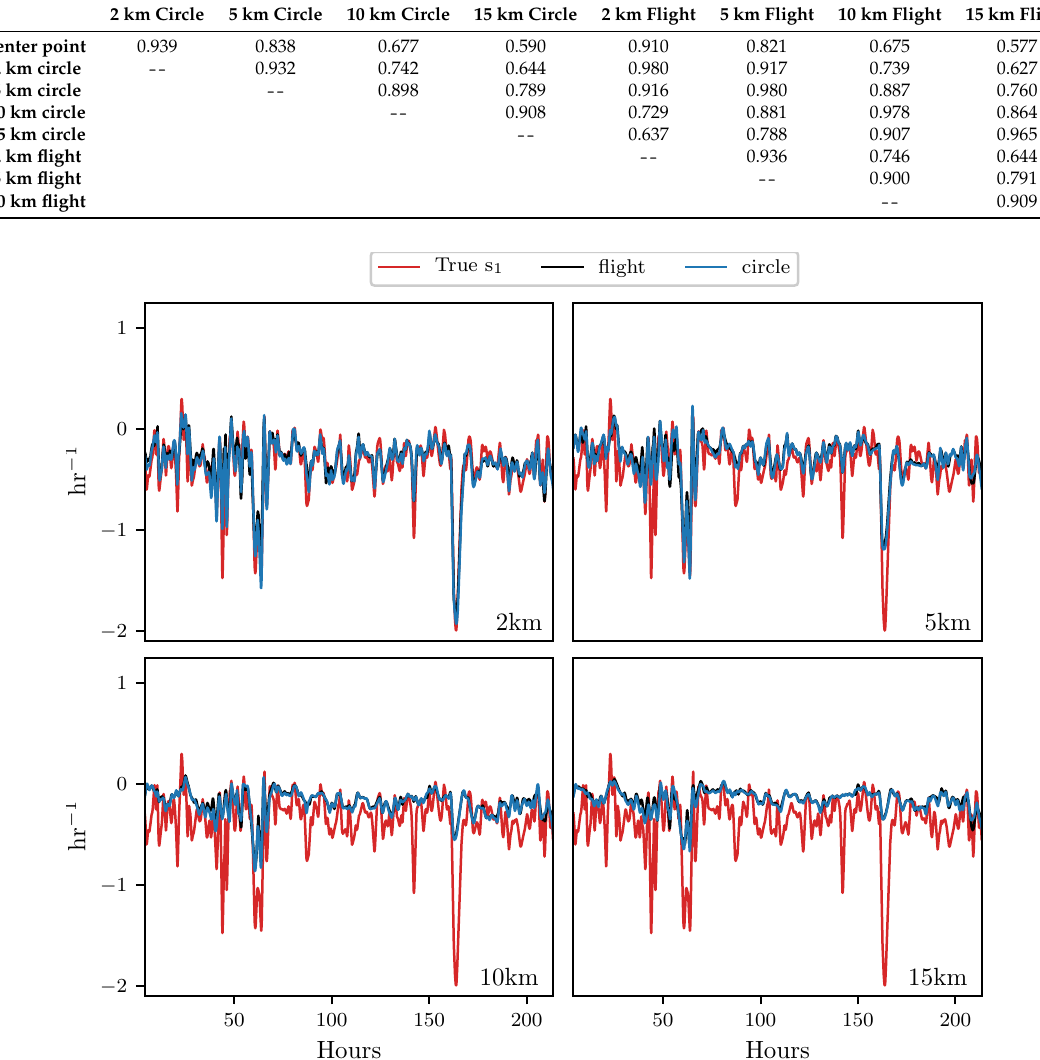
Figure 7. Comparison of measurements of the attraction rate s 1 at the center point of the circular sampling orbit ( red ), along the path of a simulated UAS flight ( black ), and along a circular arc ( blue ). The radius of the circle and flight path is shown in the lower right hand corner of each subplot. The circular arc and the simulated UAS flight are nearly on top of each